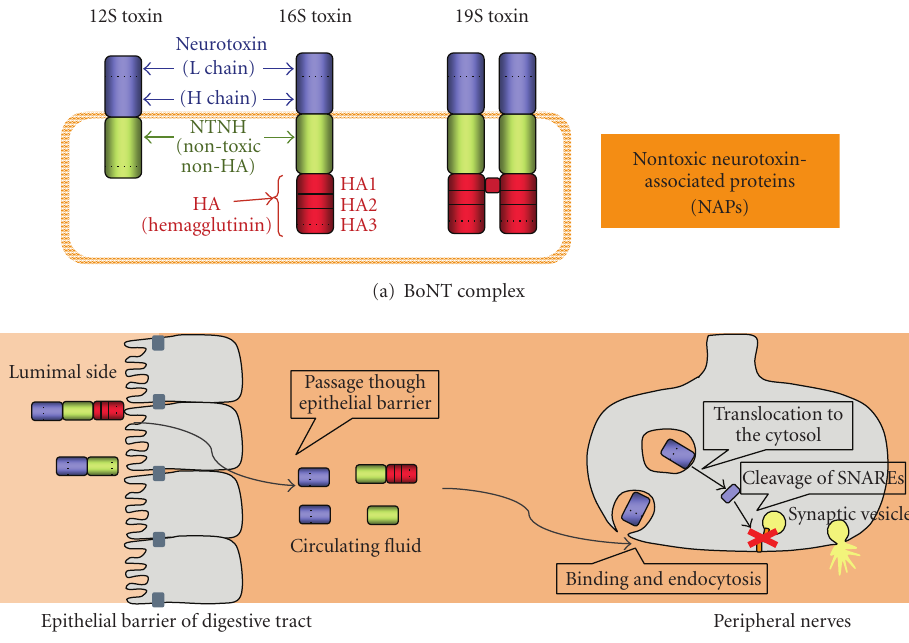
Figure 1: Botulinum neurotoxin complexes and food-borne botulism. (a) Schematic structure of botulinum neurotoxin (BoNT) complexes. (b) The pathway followed by BoNT complexes from the lumen of the intestinal tract to the cytosol of the peripheral nerve terminal in food- borne botulism. Orally ingested BoNT complexes (12S and 16S toxins) must cross the intestinal epithelial barrier to cause the food-borne botulism. After absorption from the small intestine, the botulinum neurotoxin complexes enter the lymphatic system, then the blood stream [3, 8]. In the lymphatic circulation and blood, BoNT exists as a free form dissociated from the complex [3, 9] and binds specifically to neurons [2, 10]. Inhibition of neurotransmitter release occurs via a four-step mechanism, (1) binding, (2) endocytosis, (3) translocation, and (4) cleavage of the SNARE proteins [2].